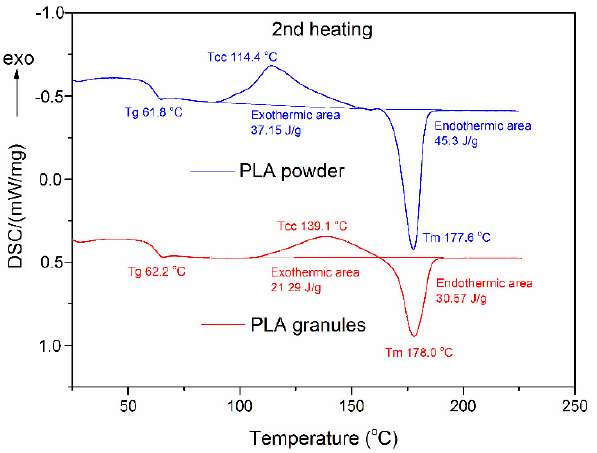
Figure 5. DSC traces of PLA in granular and powder states, obtained during the first heating scan .